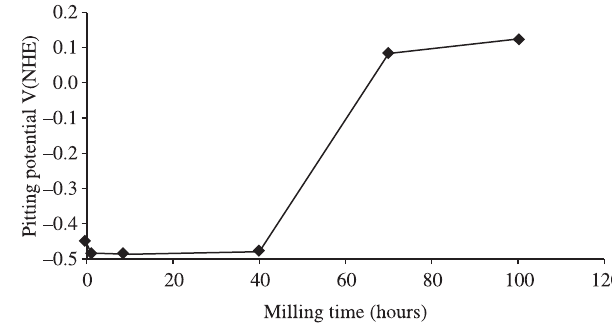
Figure 11. Pitting potential in 1M NaCl of sintered Al-15 at.Mo alloy vs. milling time.